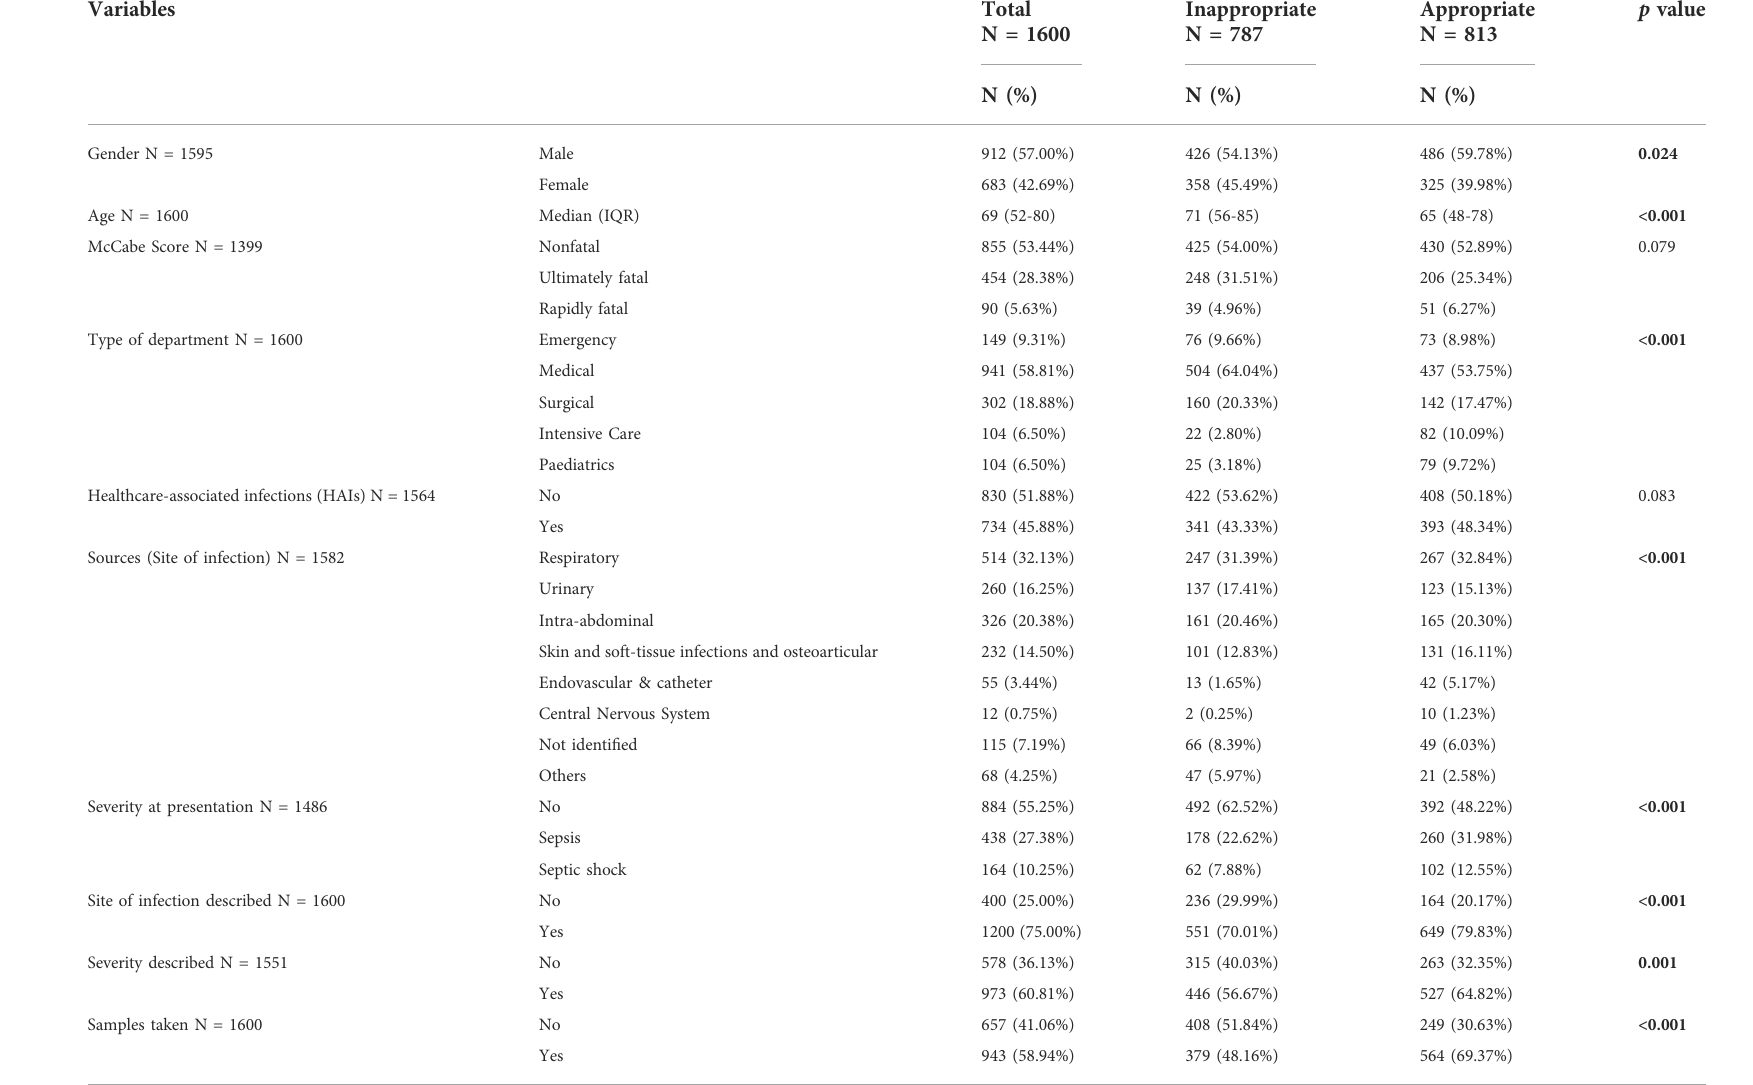
TABLE 1 Overall demographics, clinical features and antibiotics usage (N = 1600 antimicrobial